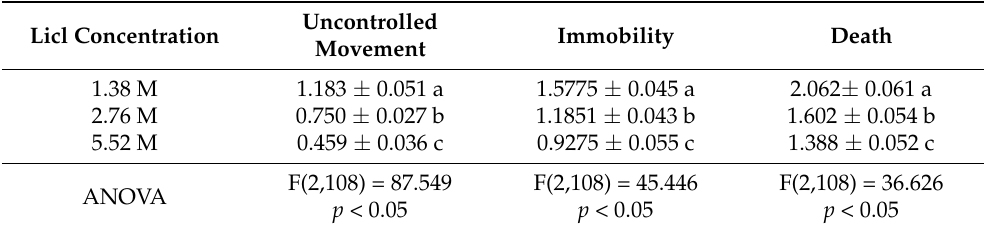
Table 2. Mean ± SE (standard error) for the log-transformed exposure times by concentration and results of the ANOVA statistics.